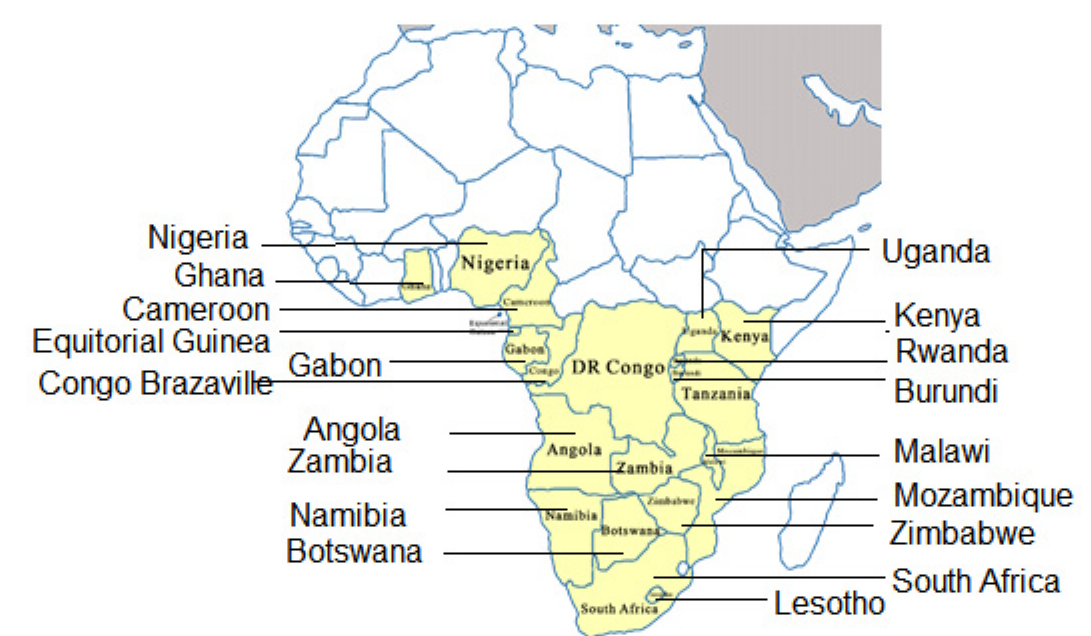
Figure 1. Ugali consumption in Africa. Countries in yellow are those that consume ugali as the main staple food; countries represented in white are those that consume ugali as one of several other staple foods.